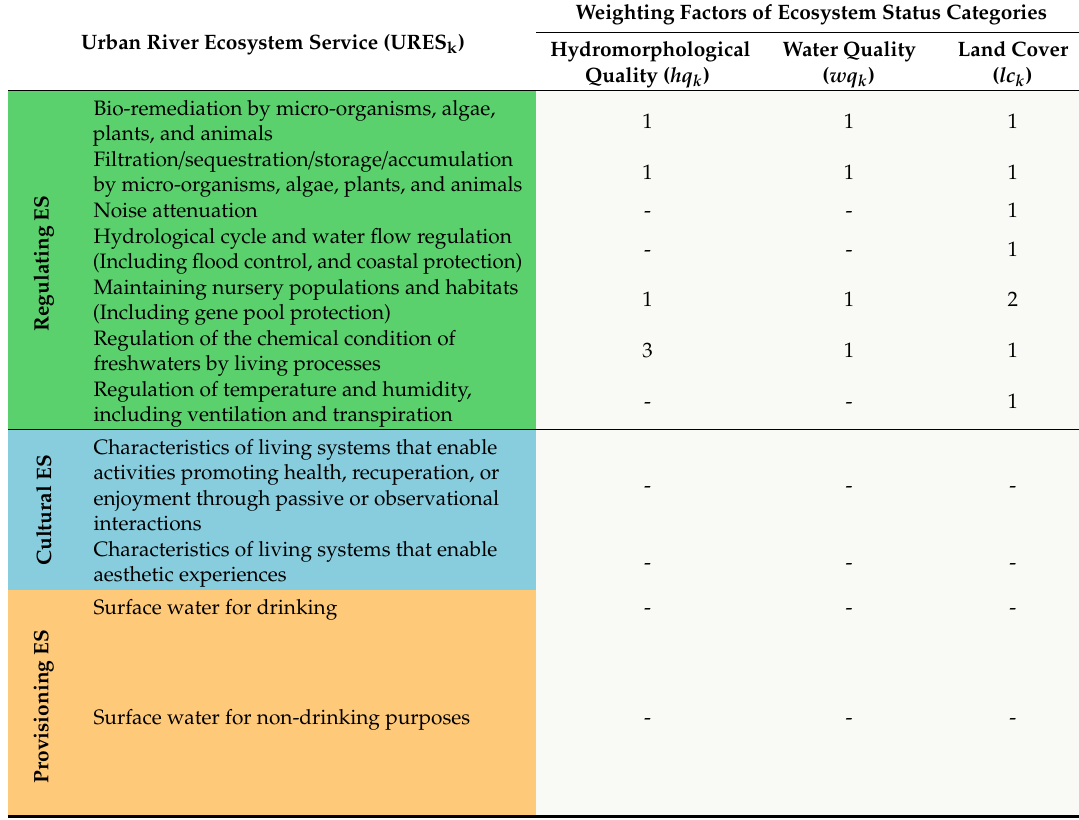
Table 3. Relations between the URES and ecosystem status